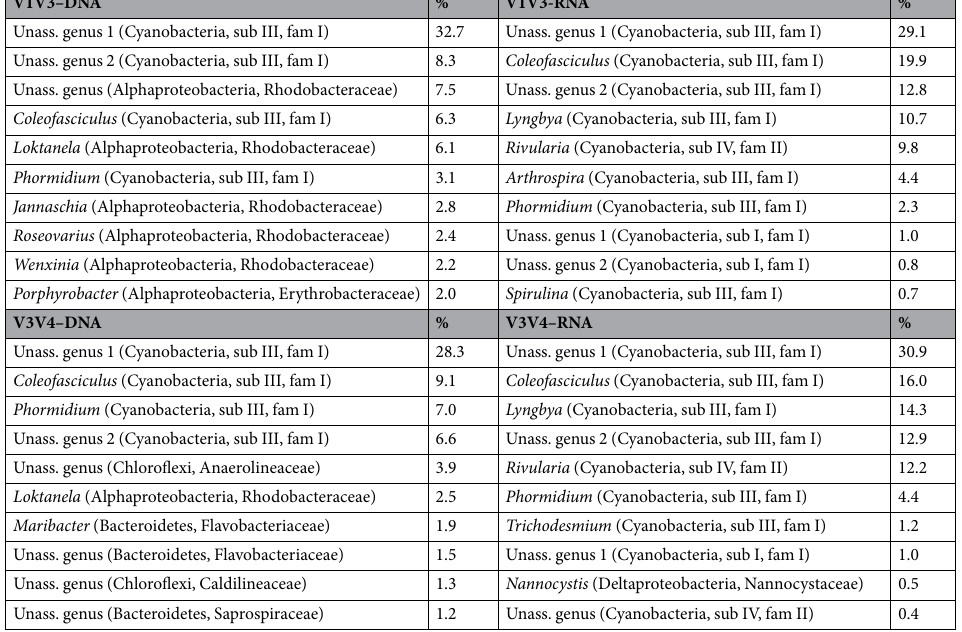
Table 2. Dominant OTUs at the genus level for both regions, V1-V3 and V3-V4 and for DNA and